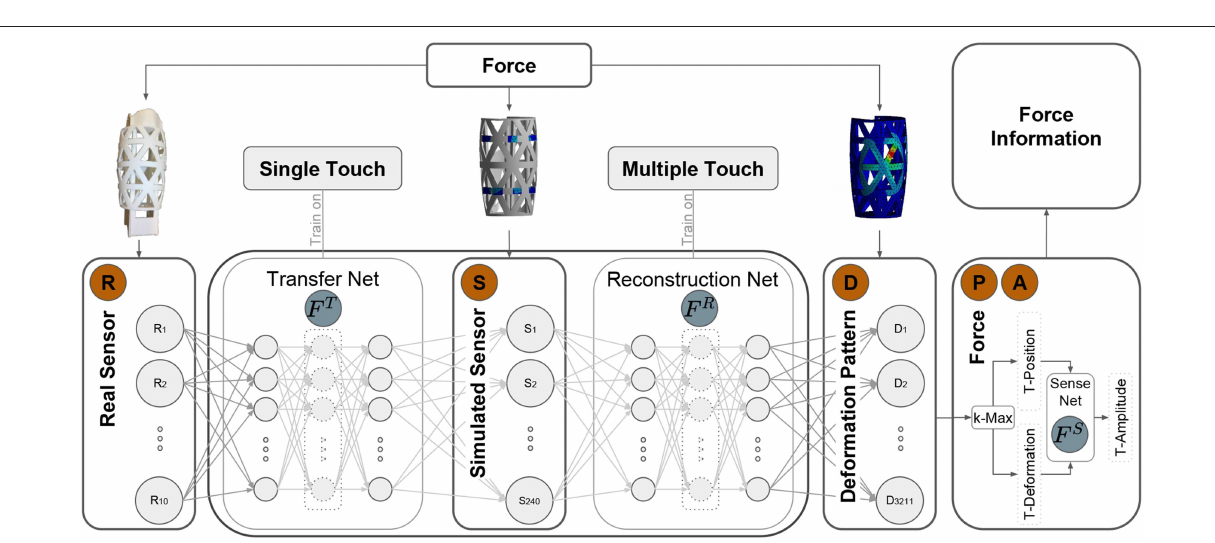
FIGURE 2 | General framework for multi-contact information inference: the framework first correlates the 10 real physical strain gauge values with the simulated sensor values using Transfer Net F T and then predicts the deformation pattern based on the simulated sensor values using Reconstruction Net F R . According to the predicted deformation pattern, the T multi-contact’s candidate locations are extracted using k-Max method. Depending on the rigidness distribution of the 3D structure, the force magnitude of each candidate contact is predicted based on the location and the deformation using Sensitivity Net F S . All predicted candidate force information is then summarized into robot system for further post-processing to cancel out the spurious